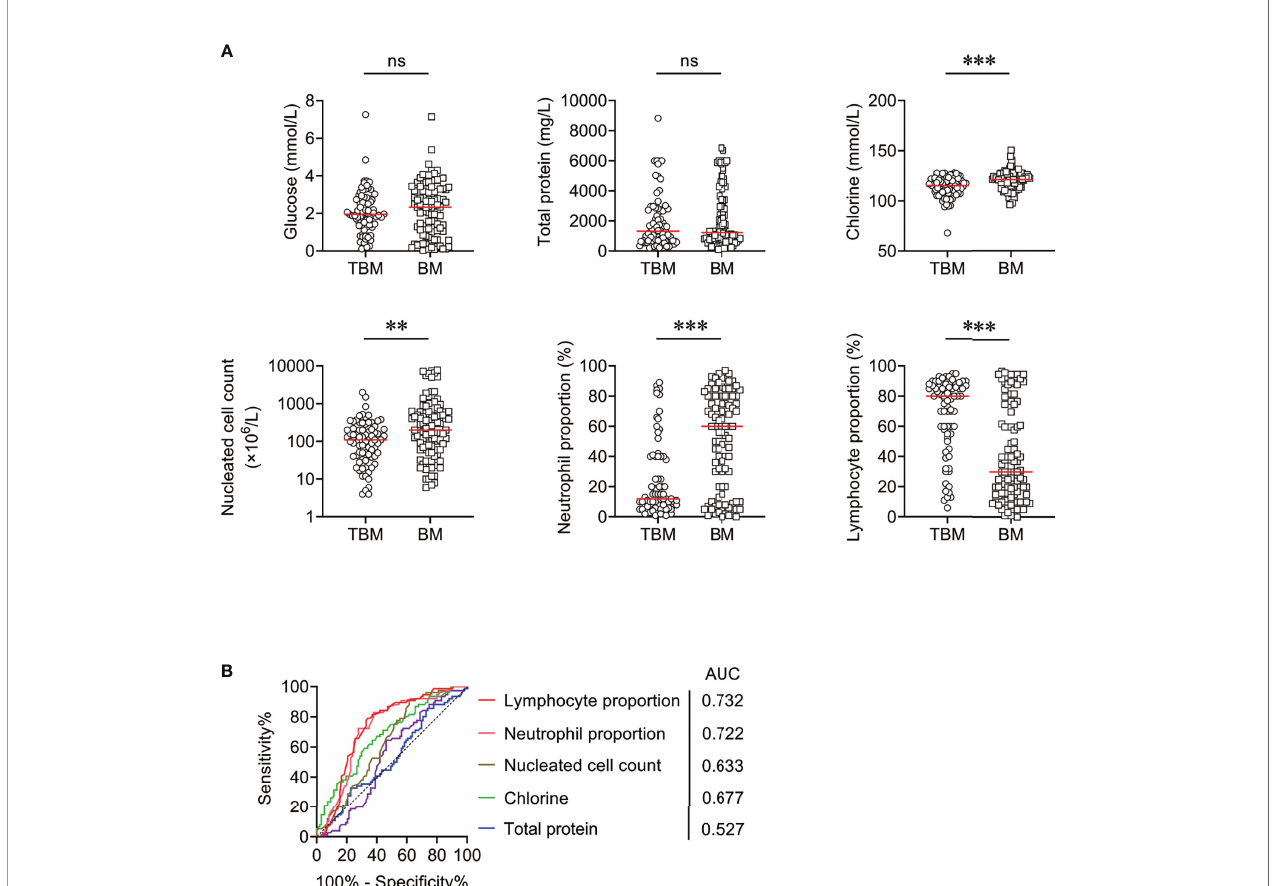
FIGURE 1 | The performance of CSF biochemical and cytological indicators for distinguishing TBM from BM in Qiaokou cohort. (A) Scatter plots showing the levels of CSF indicators including glucose, total protein, chlorine, nucleated cell count, neutrophil proportion, and lymphocyte proportion in TBM patients (n = 76) and BM patients (n = 98). Horizontal lines indicate the medians. ** P < 0.01; *** P < 0.001; ns, no signi fi cance (Mann – Whitney U test). (B) ROC curve analysis showing the performance of CSF indicators in distinguishing TBM from BM. TBM, tuberculous meningitis; BM, bacterial meningitis; ROC, receiver operating characteristic; CSF, cerebrospinal fl uid; AUC, area under the ROC